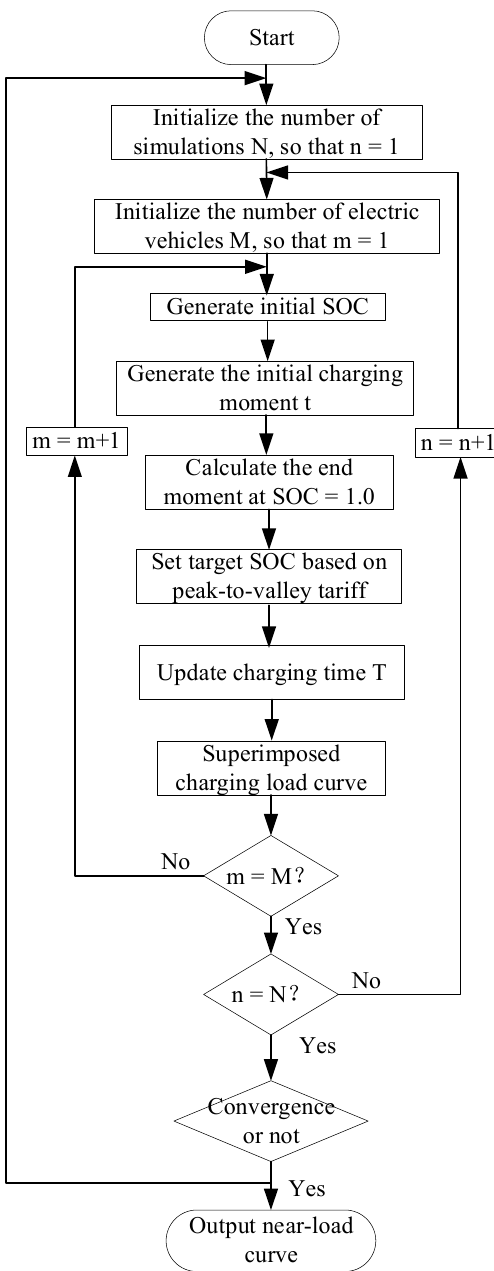
Figure 2. Monte Carlo stochastic simulation flow.